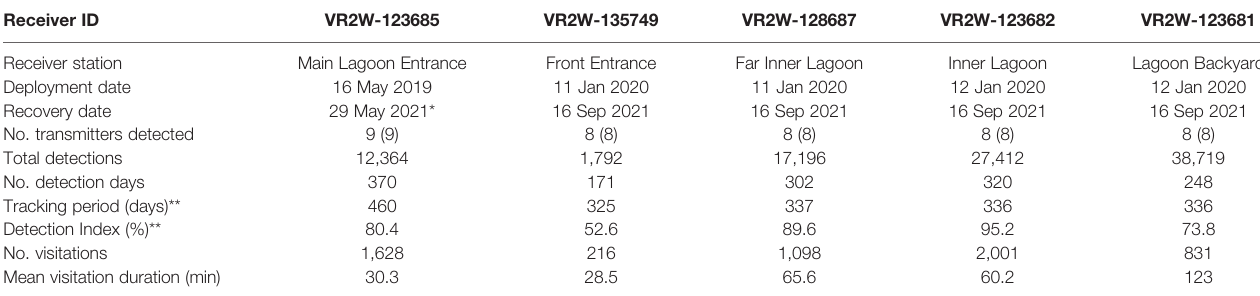
TABLE 3 | Summary of acoustic receiver deployments within the Wayag lagoon, Raja Ampat. Further explanations of metrics in the fi rst column as follows: No. transmitters detected: Total number of transmitters that were detected by the